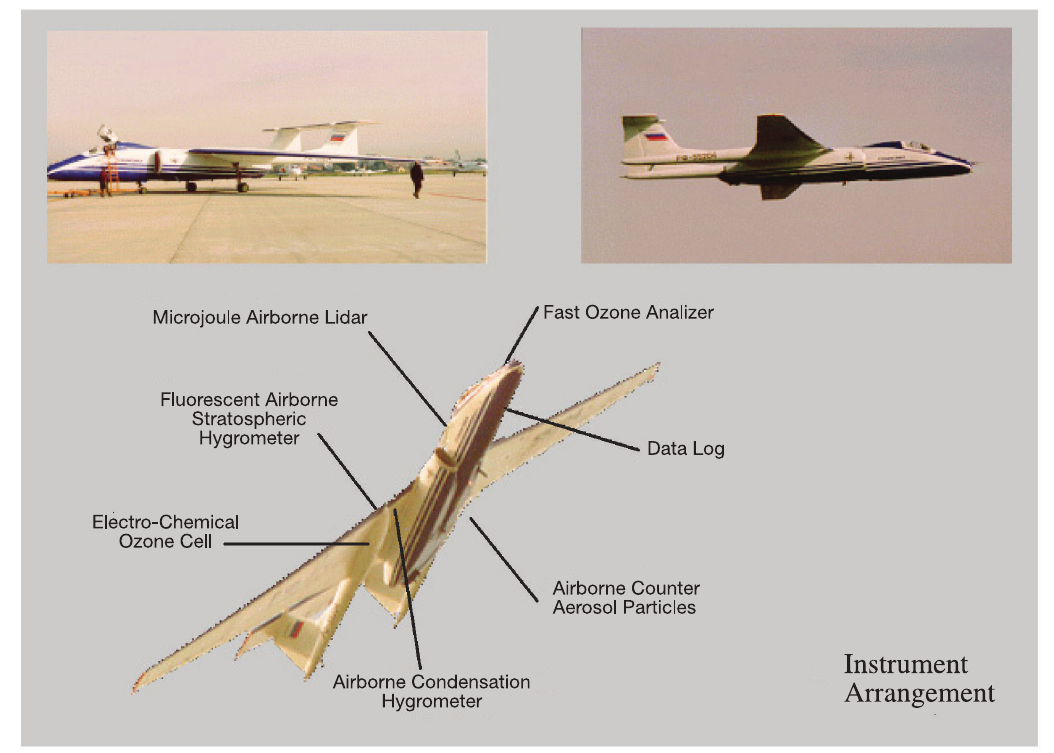
Fig. 4. The M-55 Geophysica aircraft.